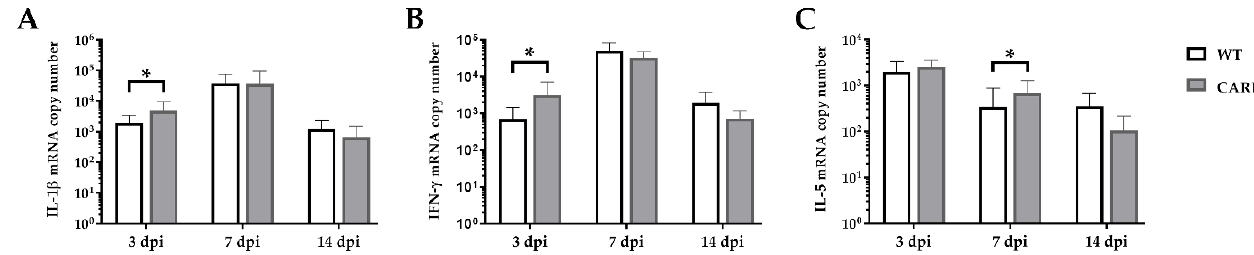
Figure 4. Cytokine mRNA expression in the cerebrum of C57BL/6 wild-type (WT) mice and CARD9 −/− mice following Theiler’s murine encephalomyelitis virus (TMEV) infection. Quantification of ( A ) interleukin (IL)-1β, ( B ) interferon (IFN)- γ and ( C ) IL-5 mRNA levels in the cerebrum by reverse transcription quantitative polymerase chain reaction (RT-qPCR). * Significant difference between WT and CARD9 −/− mice ( p ≤ 0.05; Mann–Whitney U -test). Three dpi: WT n = 10, CARD9 −/− n = 10; 7 dpi: WT n = 10, CARD9 −/− n = 9; 14 dpi: WT n = 10, CARD9 −/− n = 10. Data are displayed as mean with SD.